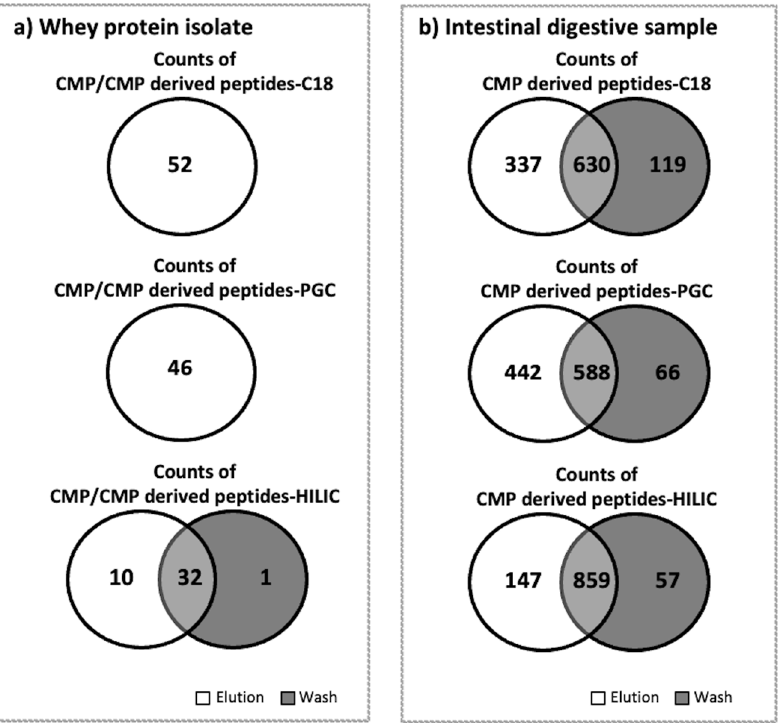
Figure 2. Venn diagrams for counts of CMP and/or CMP-derived peptides found in the elution and wash fractions of whey protein isolates or the intestinal digestive samples after the C18, PGC, and HILIC SPE. ( a ) Whey protein isolate. ( b ) Intestinal digestive sample. As no CMP or CMP-derived peptides were found in the C18 and PGC wash fractions in the whey protein isolate samples, a single circle is shown.